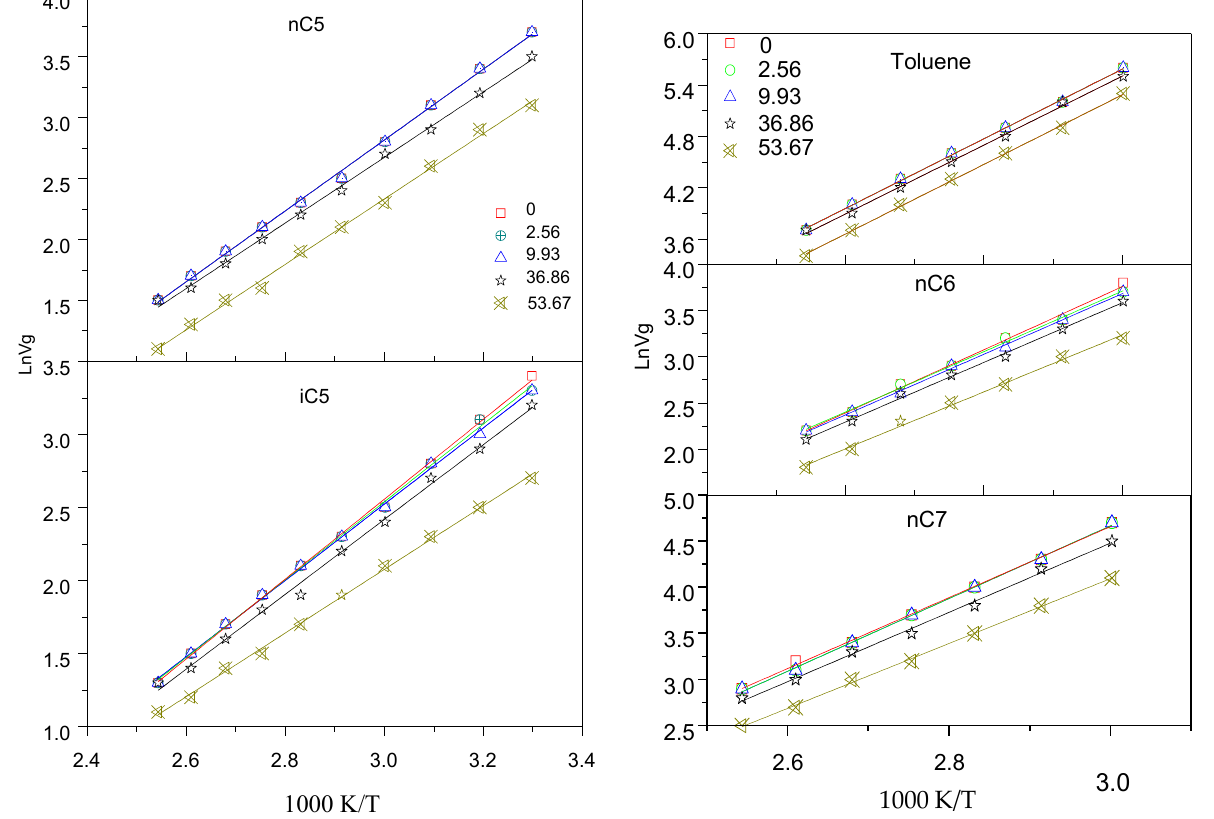
Figure 2. Linear plots for specific retention volume, ln V g , vs. the inverse of absolute temperature T: nC5, iC5, nC6, nC7, and Toluene under the different asphalting contents (0, 2.56, 9.9336.86, and 53.67 wt%).